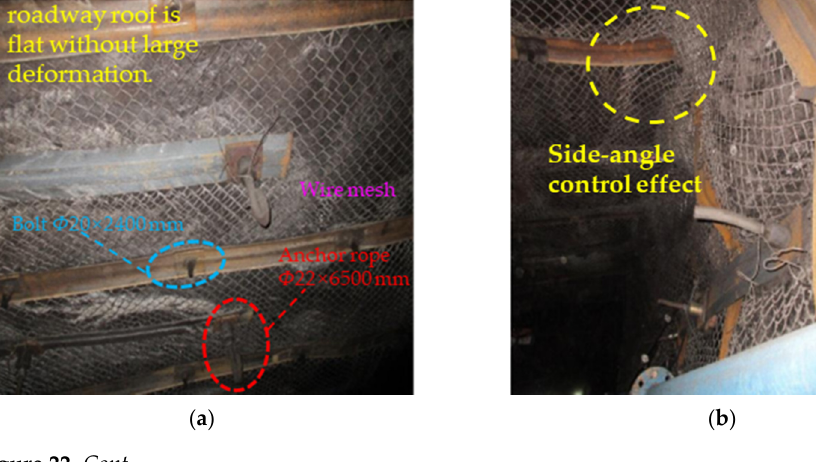
( d ) Figure 22. Application effect of the full-stress anchoring plan of bolts. ( a ) Roof control effect; ( b ) side-angle control effect; ( c ) left-side control effect; ( d ) right-side control effect. 6. Conclusions The work used theoretical analysis, laboratory simulation experiments, FLAC3D nu- merical simulation, industrial tests, and other methods to study the full-stress anchoring technology of bolts. The main conclusions obtained are as follows: (1) The mechanical equation based on the axial force and the deformation of the mi- cro-element was established by establishing the mechanical relationship model of the bolt-